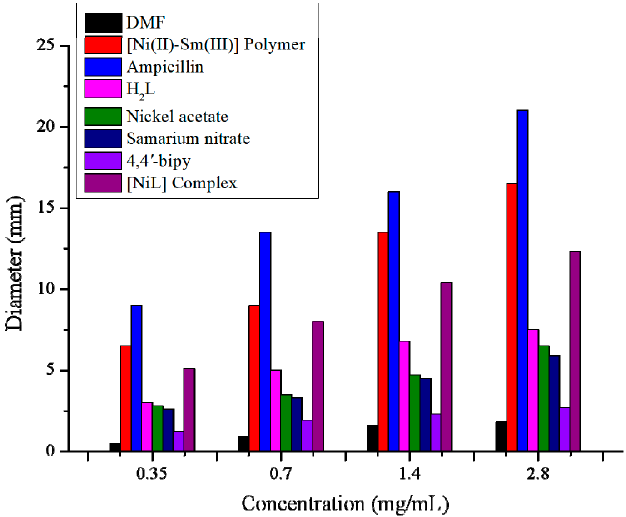
ff erent concentrations.